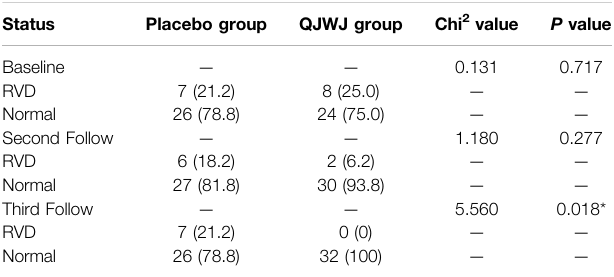
TABLE 2 | The difference of lung RVD between the two